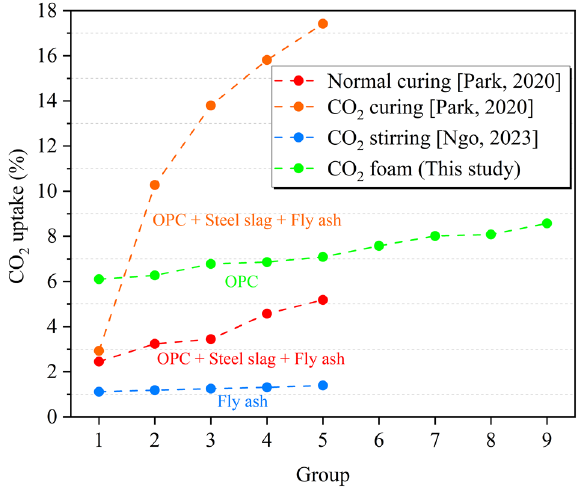
Figure 10. CO 2 uptake distribution trends of various foam concrete types [5,6].